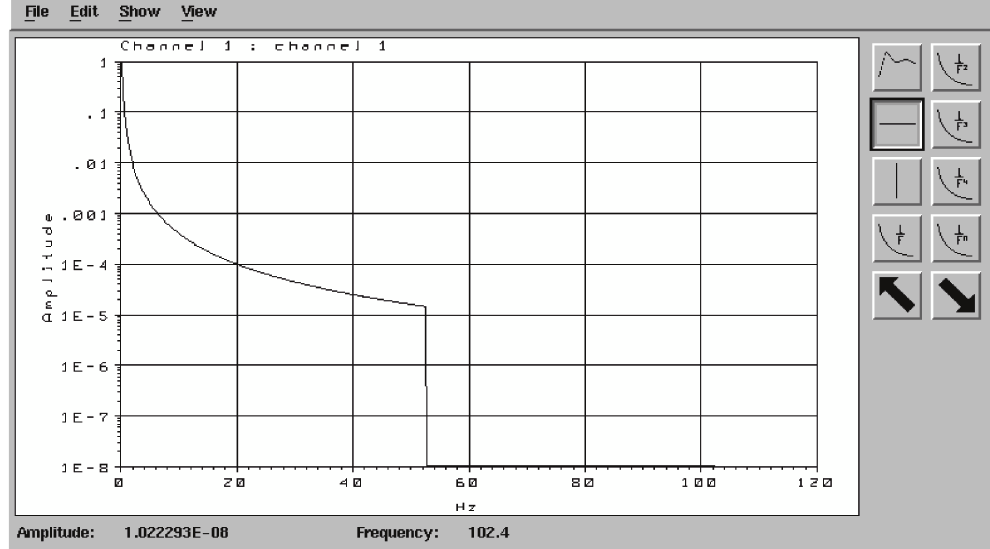
Figure 10: White/pink